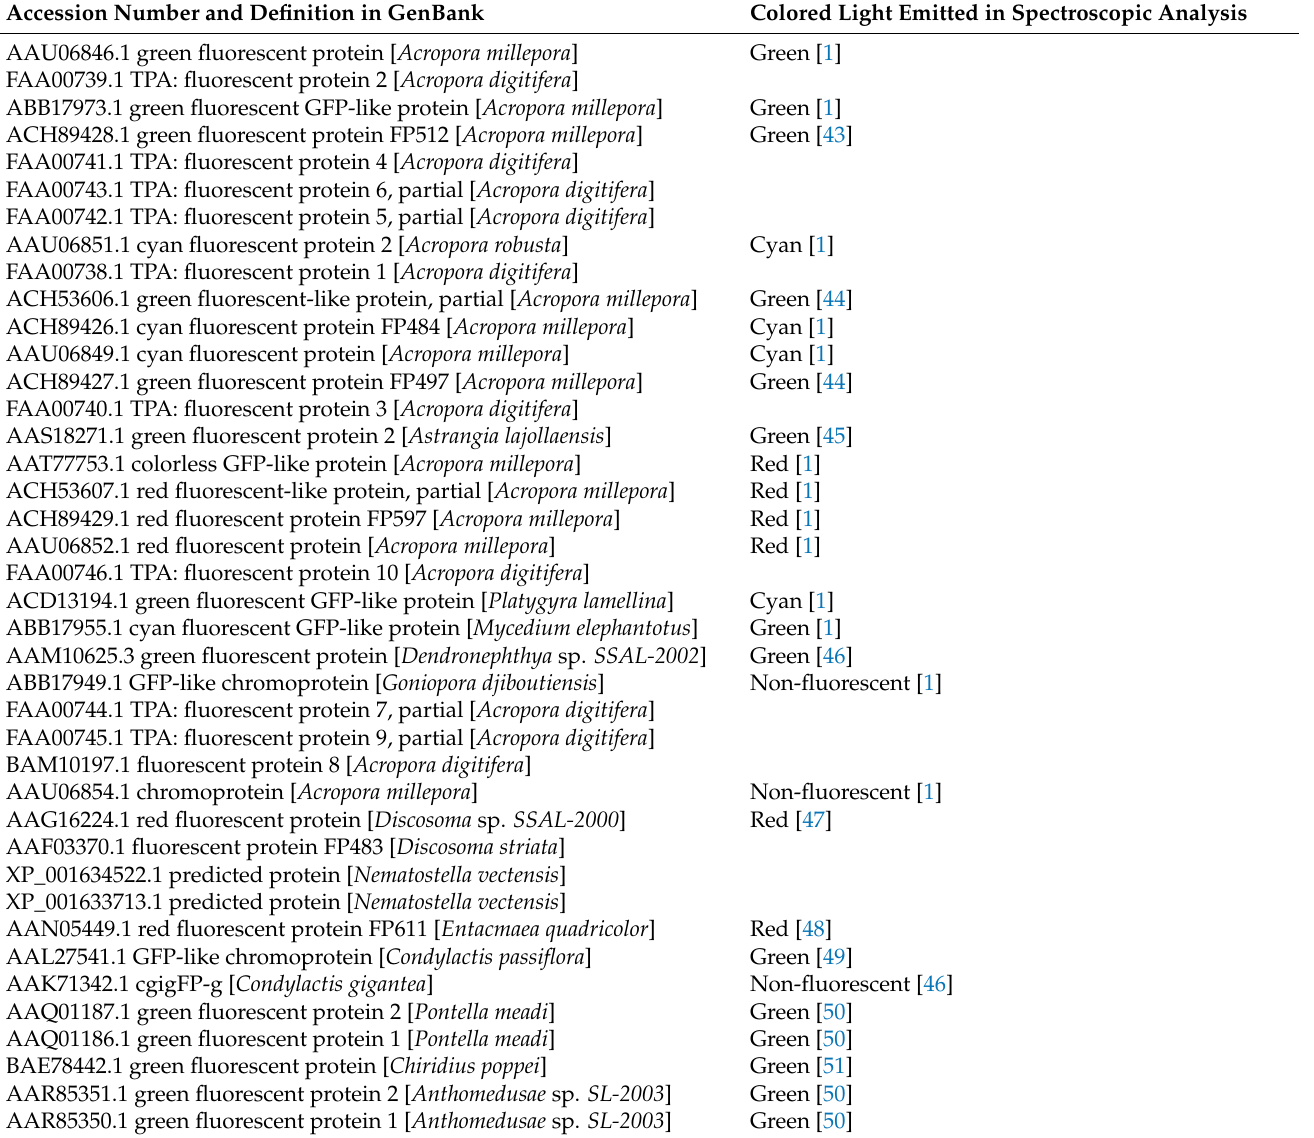
Table 1. Fluorescent proteins used as queries in this